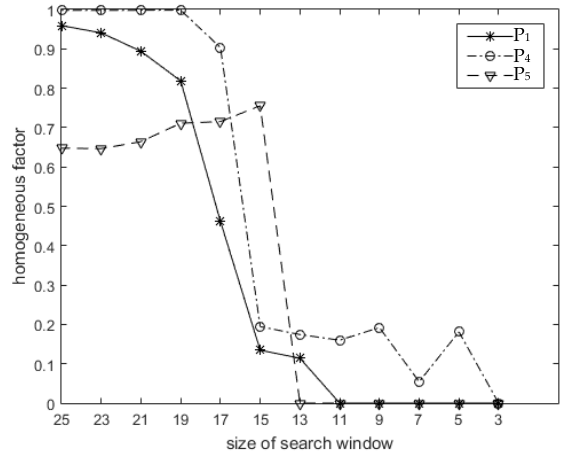
Figure 3. A variation in the homogeneous factor with a size matching the search window. The three curves correspond to P 1 , P 4 , and P 5 in Figure 2a. The initial window size was 25 and the step size for the window reduction was 2.